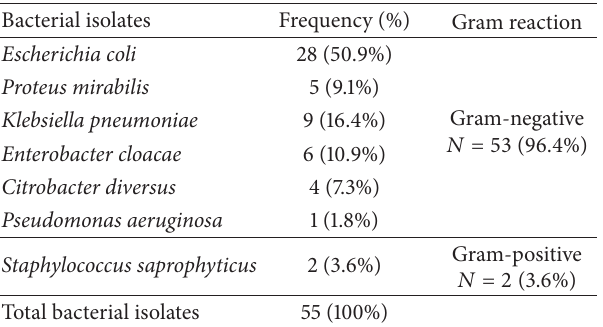
Table 1: Frequency of bacterial isolates.